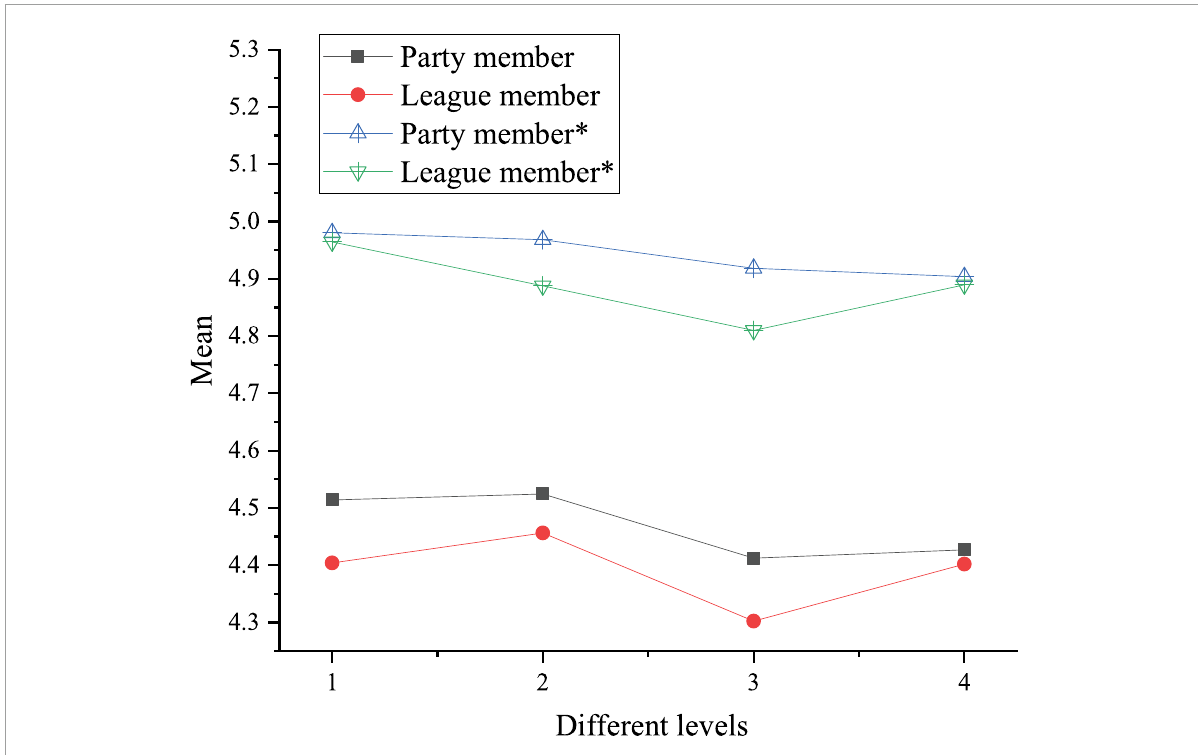
FIGURE6 Comparison of the national cognition and cultural acceptance of college students with different political statuses before and after reading art journals. * denotes post-test sample.